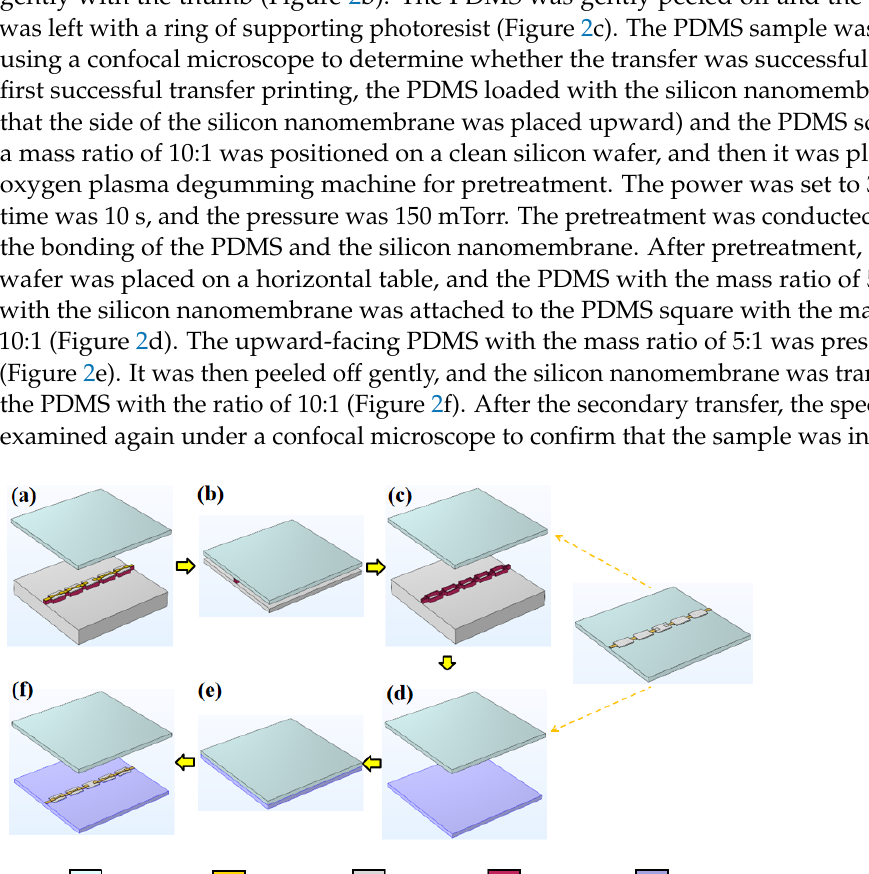
Figure 2. Process steps for transferring silicon nanomembrane. ( a ) The SOI wafer loaded with silicon nanomembrane was placed on a flat table; ( b ) it was covered with a long strip of PDMS with a mass ratio of 5:1 and pressed gently; ( c ) the PDMS was peeled off gently; ( d ) the PDMS loaded with silicon nanomembrane was attached to the PDMS square with the mass ratio of 10:1; ( e ) the upward-facing PDMS was pressed gently; ( f ) the upward-facing PDMS was peeled off gently, and then the silicon nanomembrane was transferred to the downward-facing PDMS.